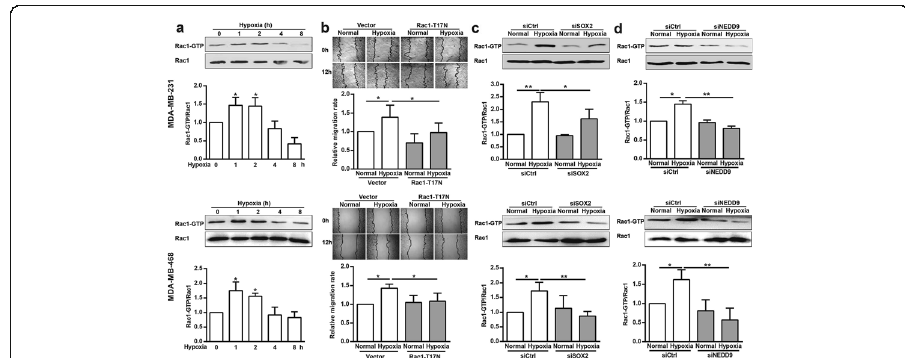
Fig. 4 Rac1 is the downstream effector of SOX2- and NEDD9-induced breast cancer cell migration under hypoxia. ( a ) MDA-MB-231 and MDA-MB-468 cells were incubated with hypoxia for the indicated time and the induction of Rac1-GTP level was determined using pulldown analysis. The data were quantified and normalized against total Rac1. * p < 0.05, referring to the difference between cells incubated with or without hypoxia. ( b ) The migratory capacity of those cells transfected with empty vector or Rac1-T17N plasmids under hypoxia was evaluated using a wound-healing assay. ( n = 10). * p < 0.05. ( c & d ) After transfection with